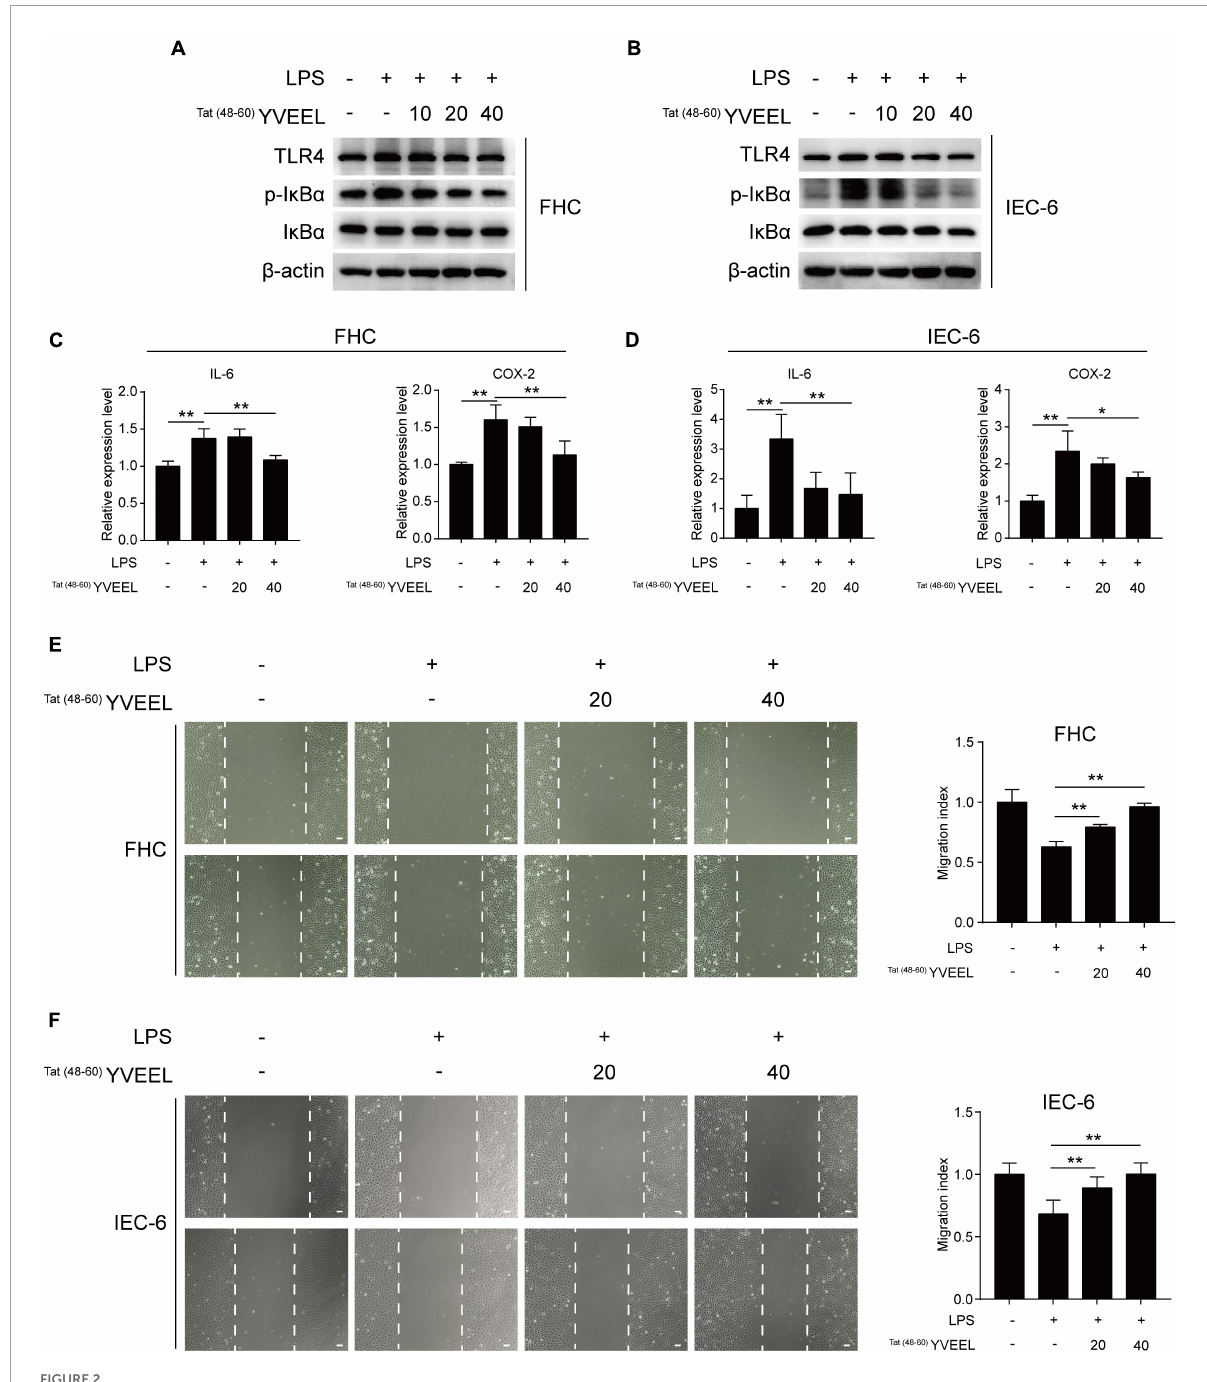
FIGURE2 Tat ( 48 - 60 ) YVEEL inhibited TLR4-mediated signaling and restored cell migration of enterocytes. Cells were pretreated with Tat ( 48 - 60 ) YVEEL at the indicated concentration (0, 10, 20, and 40 µ M) for 1 h, followed by LPS treatment. Western blot analysis of TLR4 signaling in (A) FHC and (B) IEC-6 cells after 12 h LPS treatment; mRNA expression of IL-6 and COX-2 in (C) FHC and (D) IEC-6 cells treated with LPS for 6 h in the absence or presence of Tat ( 48 - 60 ) YVEEL; cell migration after induction of mechanical scratch under Tat ( 48 - 60 ) YVEEL treatment with LPS for 12 h in (E) FHC and for 16 h in (F) IEC-6 cells; bar = 50 µ m, at × 200 magnification, the quantitative analyses of cell migration were shown in the right panel, respectively. * p < 0.05, ** p <